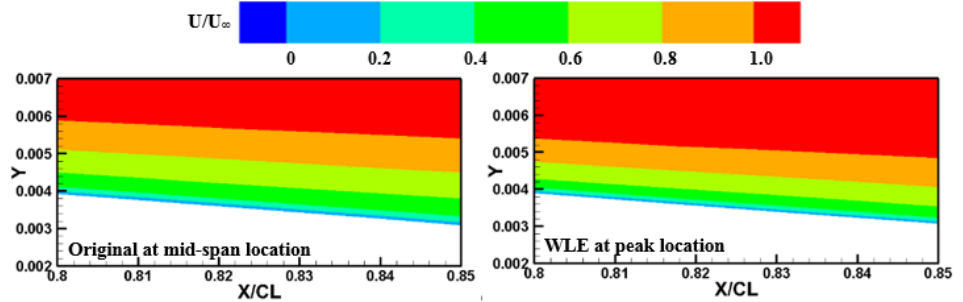
Figure 18. Comparison of the boundary layer thickness.